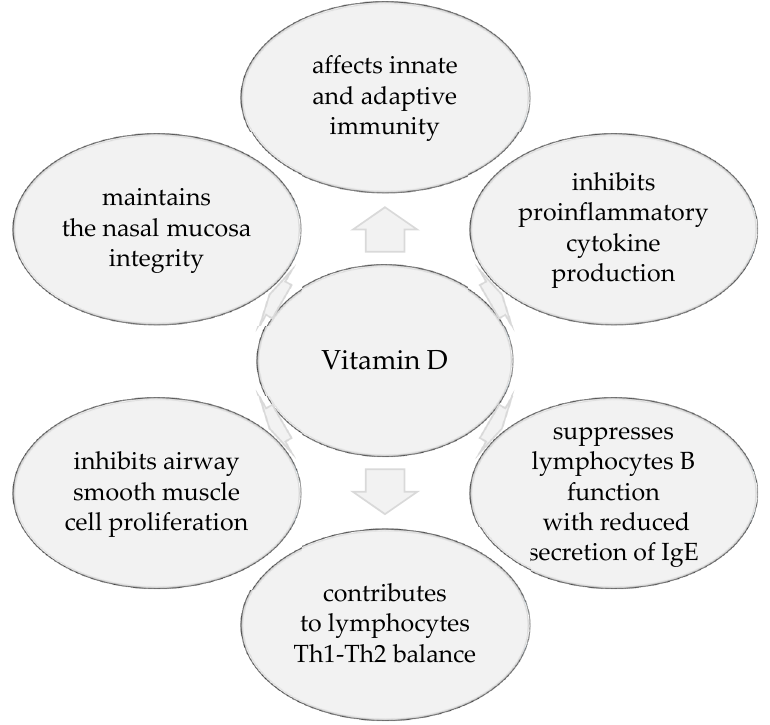
Figure 1. Protective role of vitamin D in respiratory allergic diseases.